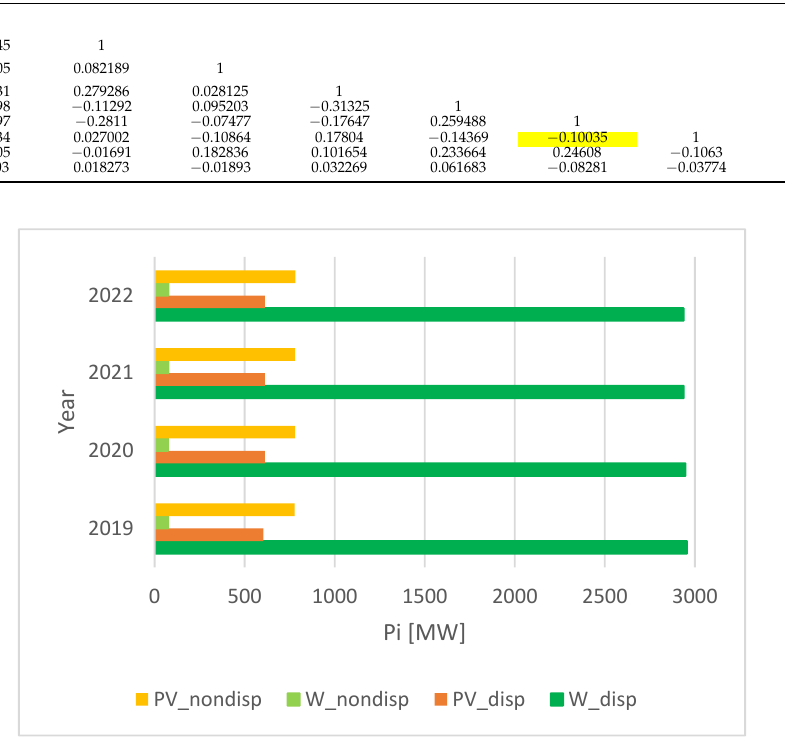
Figure 8. Installed power in wind and PV systems in Romania, 2019–2022.